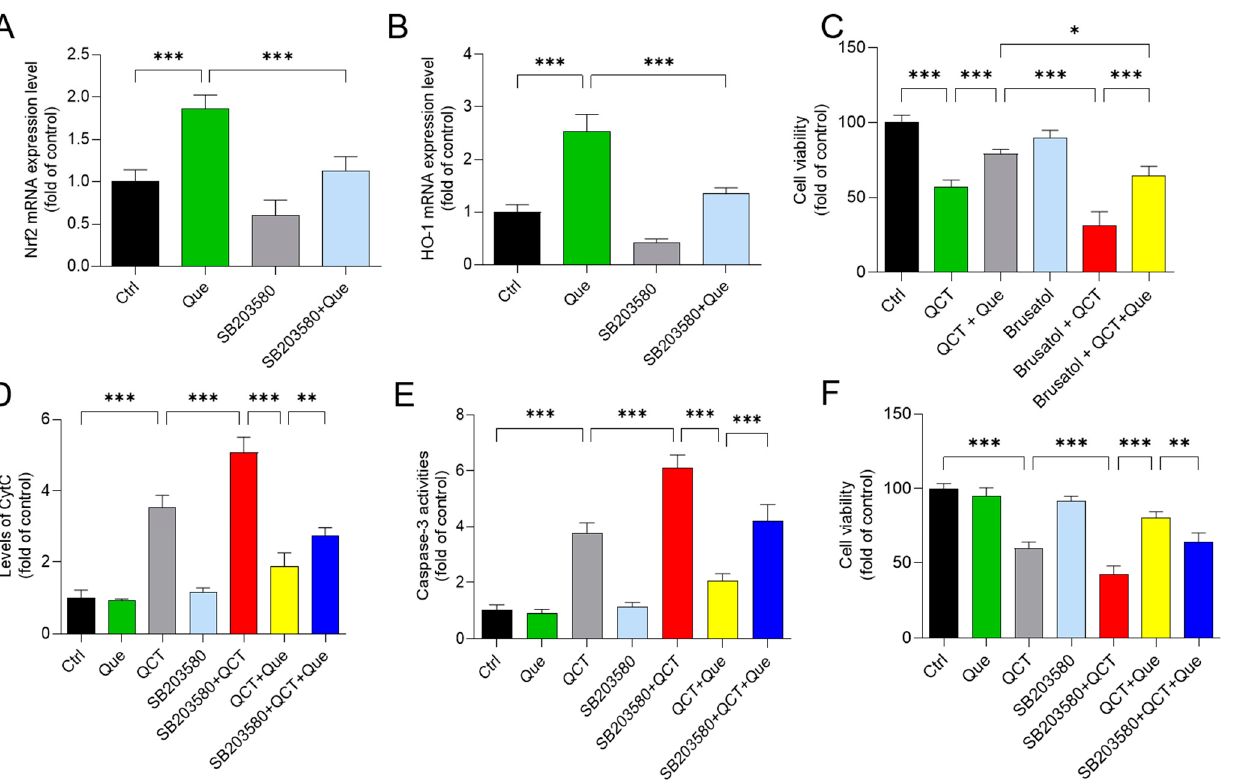
Figure 8. Inhibition of the p38 pathway attenuates the protective effect of quercetin on QCT-induced cytotoxicity in human L02 cells. A and B, the effect of p38 inhibitor treatment (i.e., SB203580 at 10 µ M) on the quercetin (at 30 µ M) -induced expression of Nrf2 ( A ) and HO-1 ( B ) mRNAs. ( C ), L02 cells were pretreated with Que at 30 µ M or co-treated brusatol at 40 nM for 2 h, followed by treatment with or without QCT at a final concentration of 5 µ g/mL for an additional 24 h. Finally, the cell viability was measured. D-F, L02 cells were pretreated with Que at 30 µ M or co-treated SB203580 at 10 µ M for 2 h, followed by treatment with or without QCT at a final concentration of 5 µ g/mL for an additional 24 h. Finally, the release of CytC ( D ), the activation of caspase-3 ( E ), and cell viabilities ( F ) were measured, respectively. All results were presented as mean ± SD ( n = 4 independent experiments). * p < 0.05, ** p < 0.01, and *** p < 0.001, compared between the two groups. QCT, quinocetone; Que, quercetin.